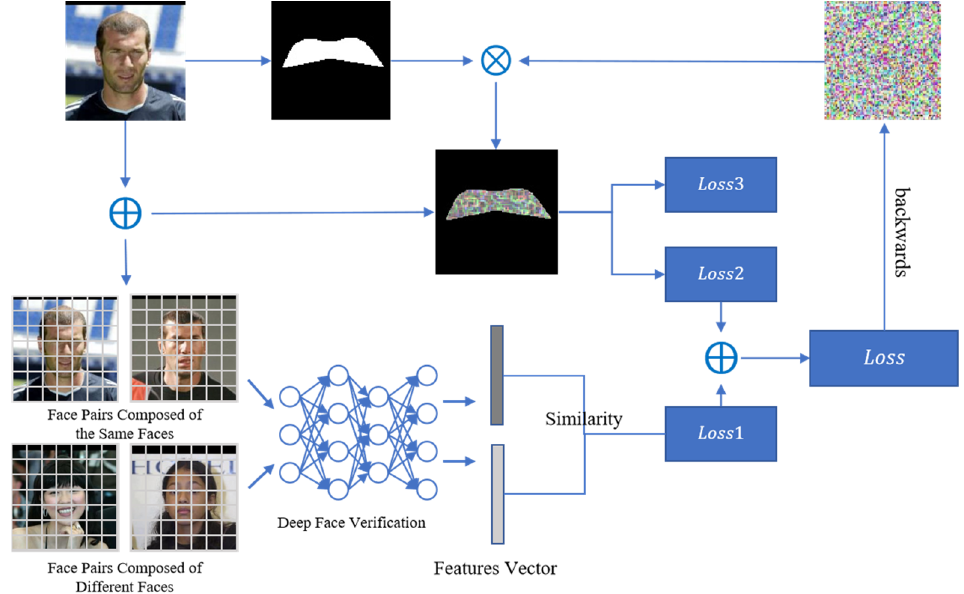
Figure 8. Flowchart of the adversarial attack based on the eye area.